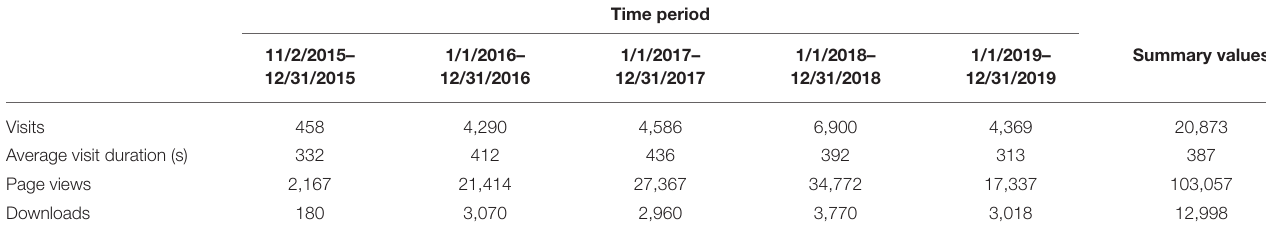
TABLE 8 | NCS archive site visit